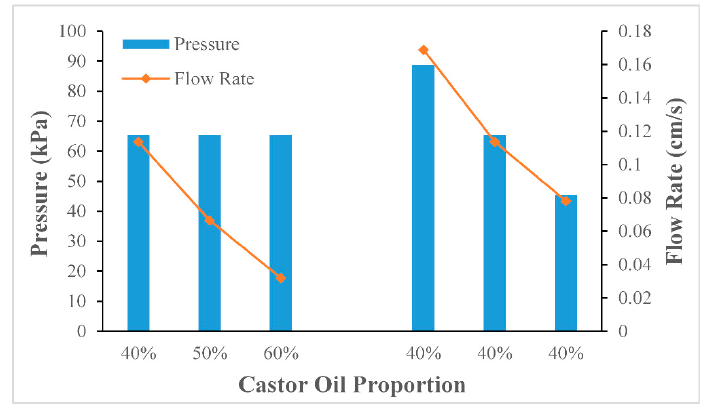
Figure 5. Average flow velocity under different viscosity ( left ) and average flow velocity under average pressure ( right ).